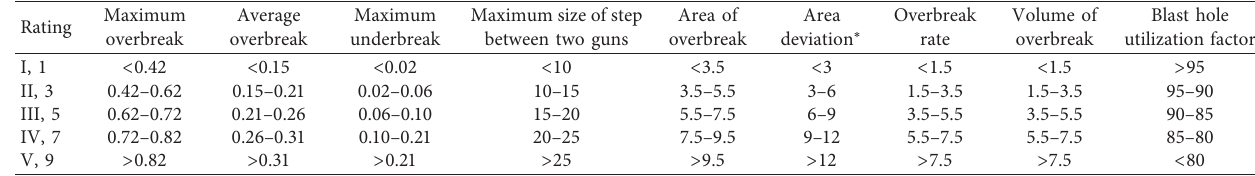
Table 14: Rating of each evaluation index for tunnel contour quality (for medium-hard rocks).